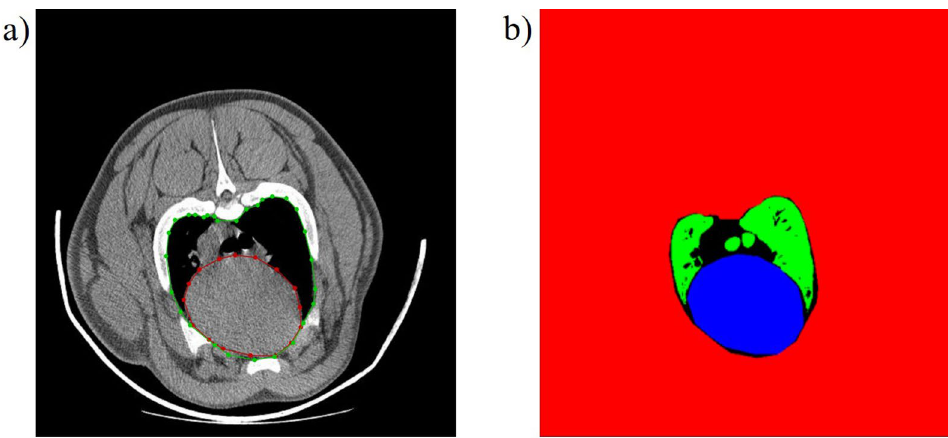
Figure 1. Manual annotation of CT-image. ( a ) Polygons covering the heart only (red) and heart and lung area combined (green). ( b ) Final labelling of heart (in blue), the lungs (in green) and background (in red). The region coloured in black is not assigned to any